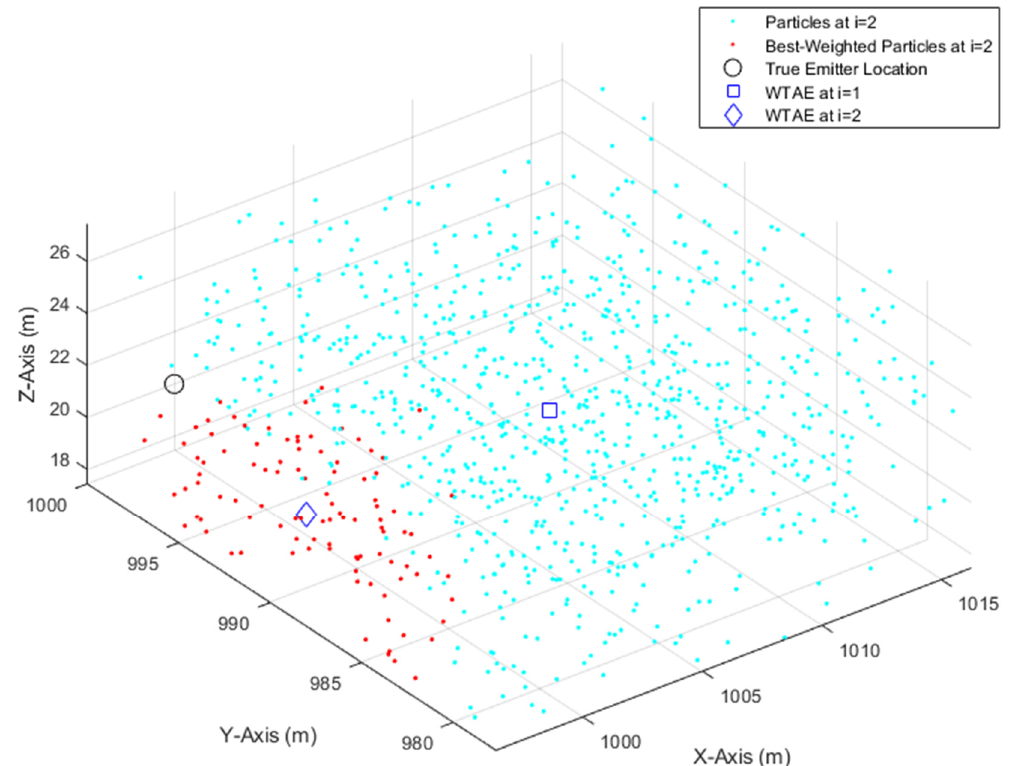
Figure 3. Illustration of the IPF implementation.